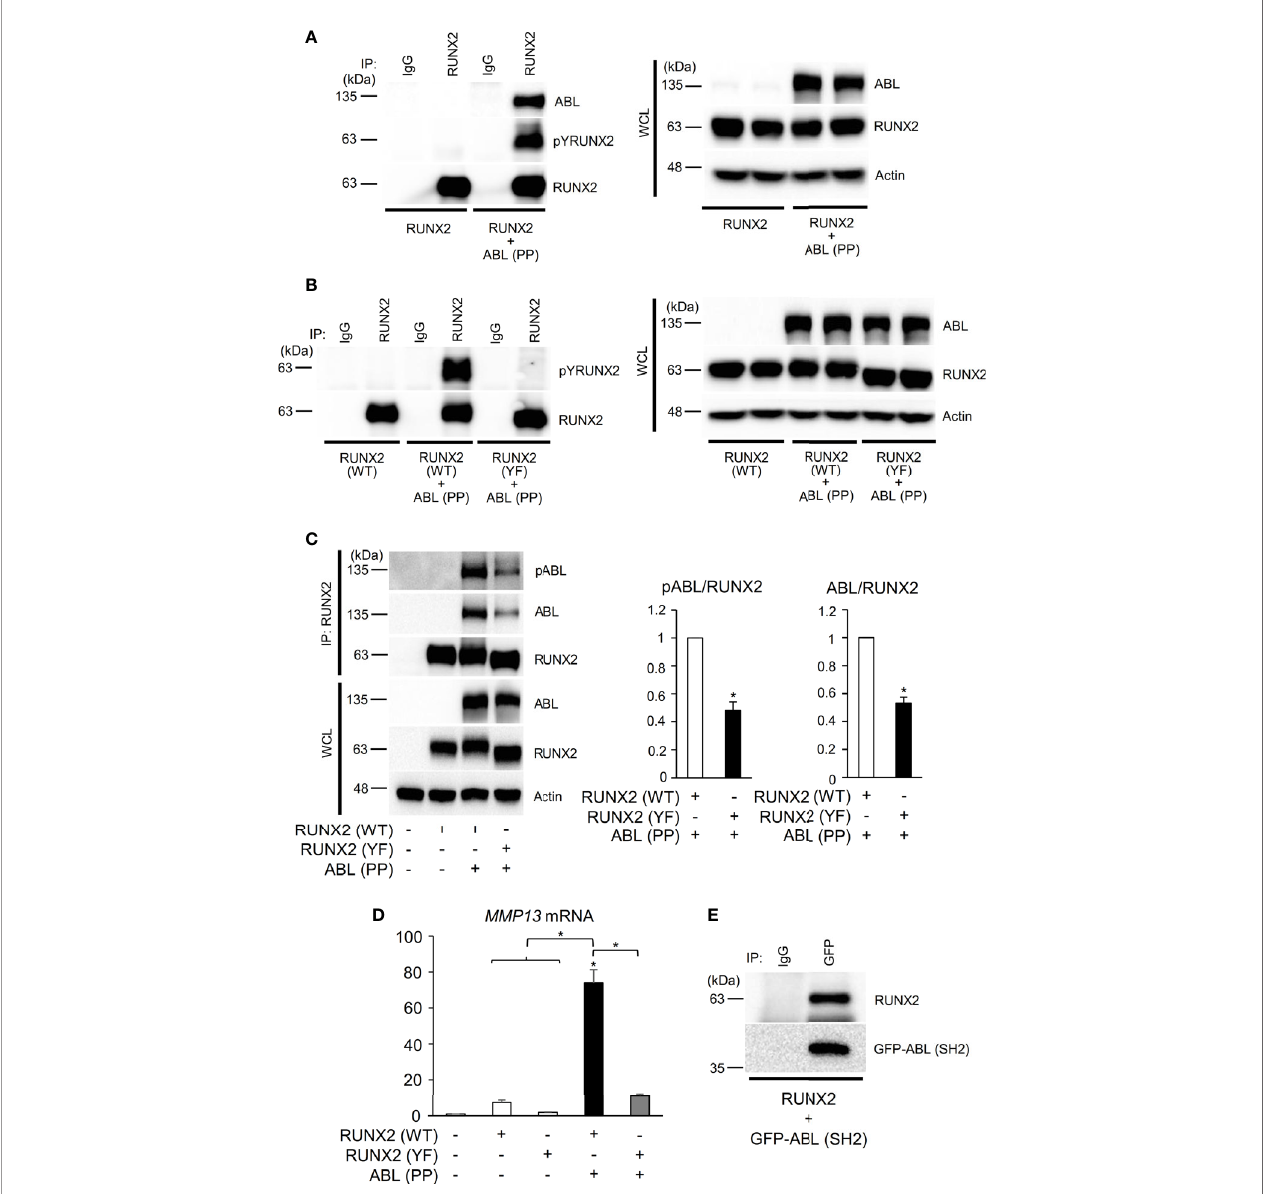
FIGURE 2 | ABL binds to, phosphorylates, and activates RUNX2 through its SH2 domain. (A – C) HEK293T cells were co-transfected with wild-type (WT) or all tyrosine to phenylalanine mutant (YF) RUNX2 with or without ABL (PP). RUNX2 immune complexes were probed with an anti-phosphotyrosine (4G10), anti- pY245ABL, anti-ABL or anti-RUNX2 antibody. Whole cell lysates (WCL) were probed with the indicated antibodies for Western blot analysis. (D) Quantitative PCR analysis of MMP13 mRNA expression in HEK293T cells co-transfected with RUNX2 (WT or YF) with or without ABL (PP). n = 3. (E) HEK293T cells were co- transfected with RUNX2 with or without GFP-ABL (SH2). GFP-ABL (SH2) immune complexes were probed with an anti-RUNX2 or anti-GFP antibody. P values were determined by ANOVA with Tukey – Kramer ’ s post hoc test. Data are presented as means ± SEM. *P <